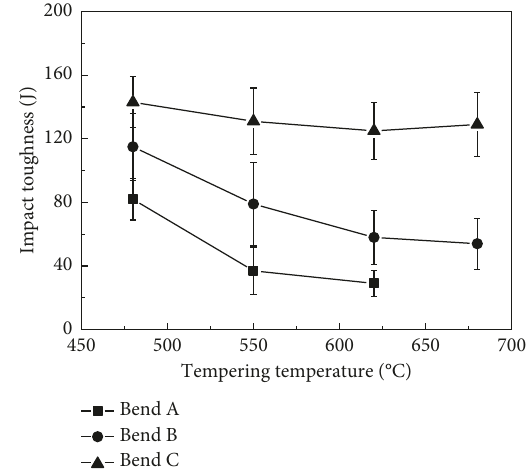
Figure 5: Effect of tempering on the Charpy impact